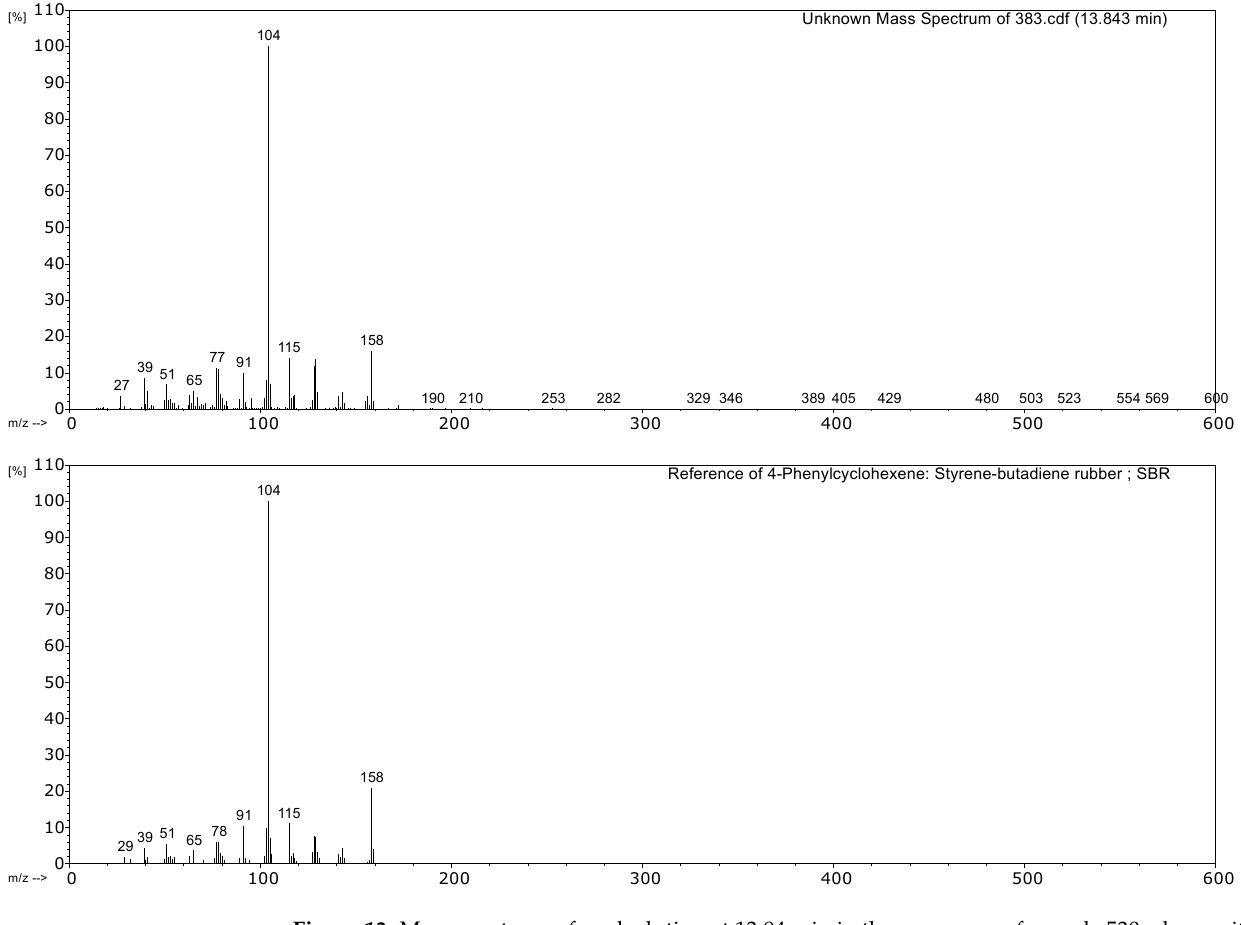
Figure 13. Mass spectrum of peak eluting at 13.84 min in the pyrogram of sample 530, along with a reference spectrum (F ‐ Search database).